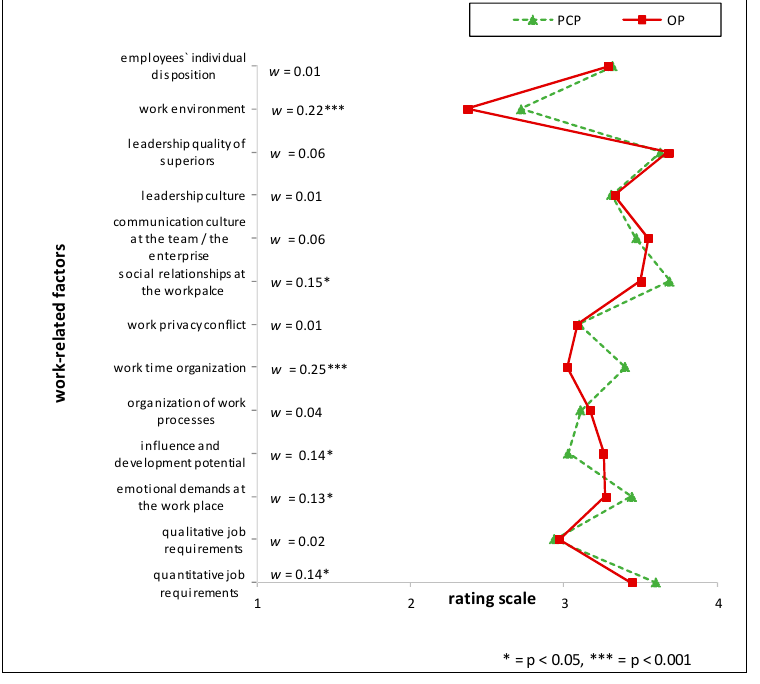
Figure 4. Polarity profile across work-related factors potentially important for (stress-associated) mental disorders in employees comparing the mean value ratings from “not at all important” (1) to “very important” (4) of Occupational Physicians (OP) and Primary Care Physicians (PCP), w = effect size of differences.